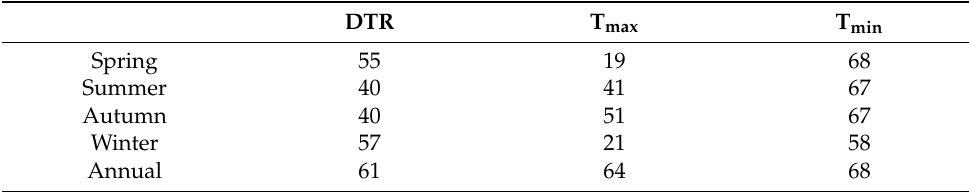
Figure 3. Time series of annual mean DTR, T max , and T min in northeast China from 1961 to 2015. The solid lines represent the linear fit. Table 1. Number of stations that reach the significant level ( p <